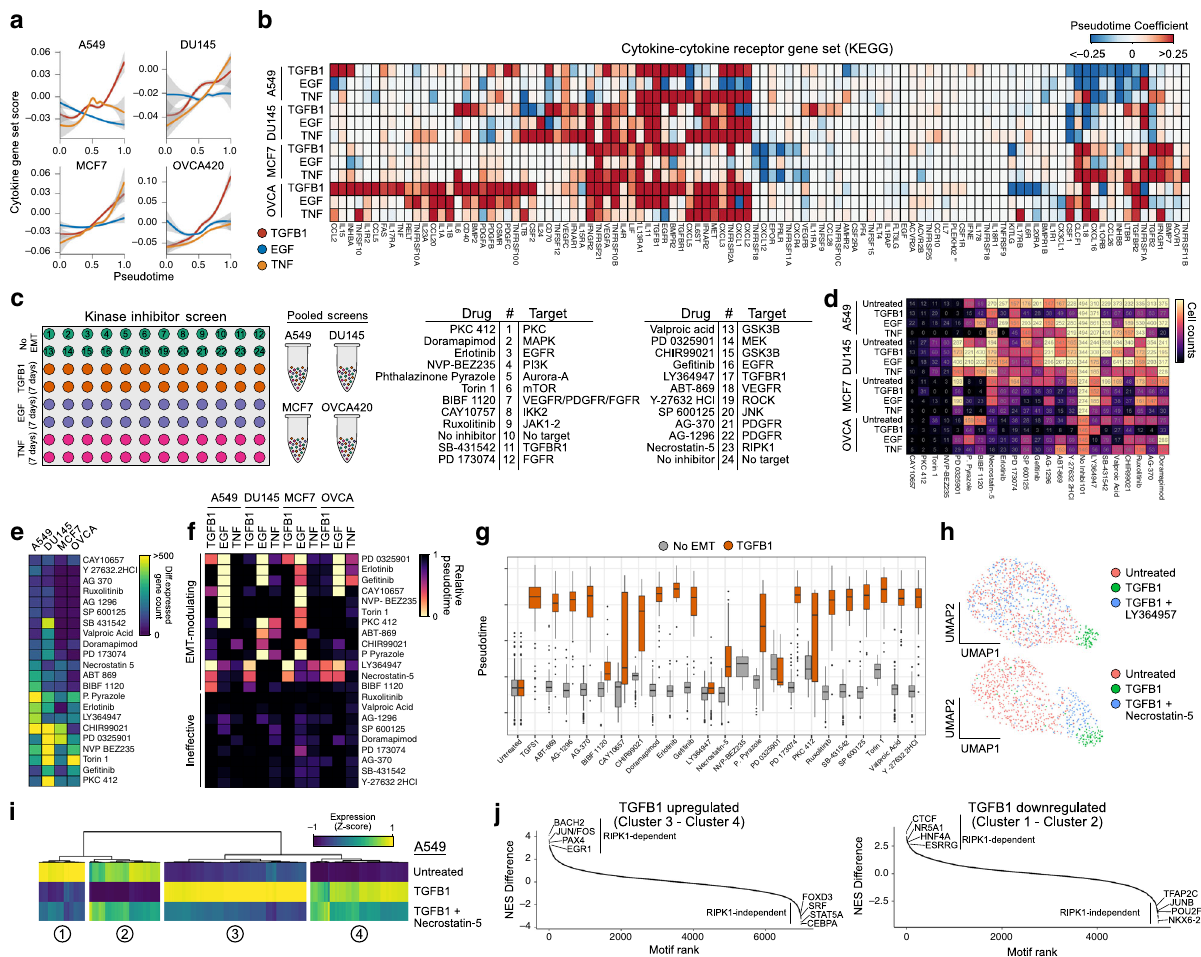
Fig. 4 Kinase inhibitor screens identify signaling dependencies of the EMT. a Gene set score of the KEGG pathway “ cytokine – cytokine receptor interaction ” over pseudotime for each time course experiment. Shaded bands for each line correspond to the standard error for each model. b Heatmap showing EMT-associated changes of the individual genes of the same gene set as in a , only listing those with a signi fi cant change in at least one time course experiment. c Schematic of the 384-sample experimental design for the kinase inhibitor screen. d Heatmap showing the number of cells annotated to each condition after demultiplexing the scRNA-seq data. e Summary of the number of genes that are differentially expressed in each cell line exposed to the inhibitors without EMT induction. f Average pseudotime values calculated for each condition. g Boxplots showing the distribution of pseudotime values for A549 cells treated with the inhibitors alone (grey) or in combination with TGFB1 (orange). The horizontal black line of the boxplot represents the median value, the box spans the 25th and 75th percentiles, and whiskers correspond to 1.5 times the interquartile range. h UMAP embeddings of untreated A549 cells with those had been treated with TGFB1 alone or in combination with the TGFBR1 inhibitor LY364947 (top), or the RIPK1 inhibitor necrostatin-5 (bottom). i Heatmap showing expression ( Z -score) of genes differentially expressed in A549 cells by TGFB1 in untreated A549 cells, as well as those treated with TGFB1 alone or in combination with necrostatin-5. j Difference in normalized enrichment scores for transcription factor targets in genes that are successfully inhibited by necrostatin-5 compared to those that are not. Positive values correspond to regulons with that are enriched in necrostatin-5- inhibited genes, whereas negative values represent those are not affected by